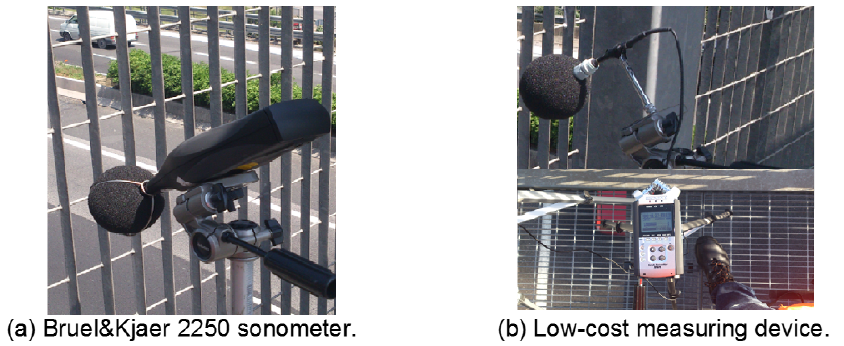
Figure 1. Recording